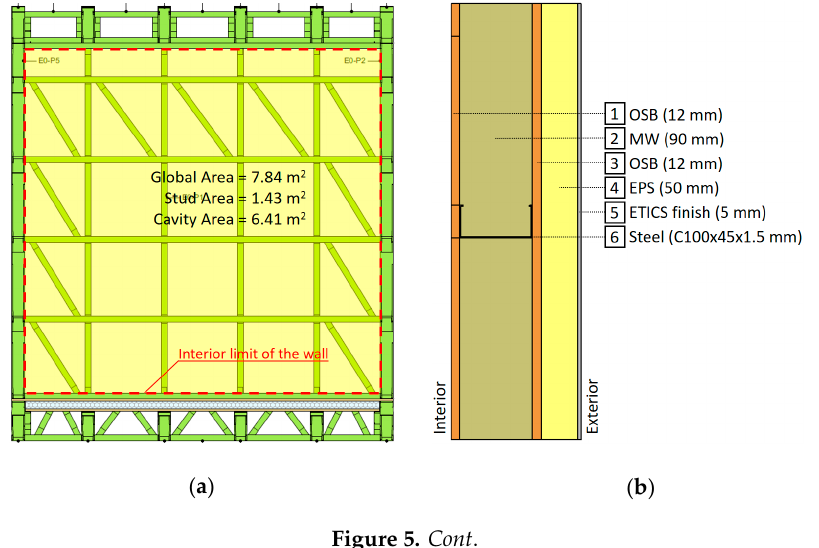
Figure4. LSFceilingelement: ( a )Planviewoftheceilingsteelframe; ( b )THERMmodel; ( c )Temperature Figure 4. LSF ceiling element: ( a ) Plan view of the ceiling steel frame; ( b ) THERM model; ( c ) color distribution and obtained U Temperature color distribution and obtained 𝑈 -value.